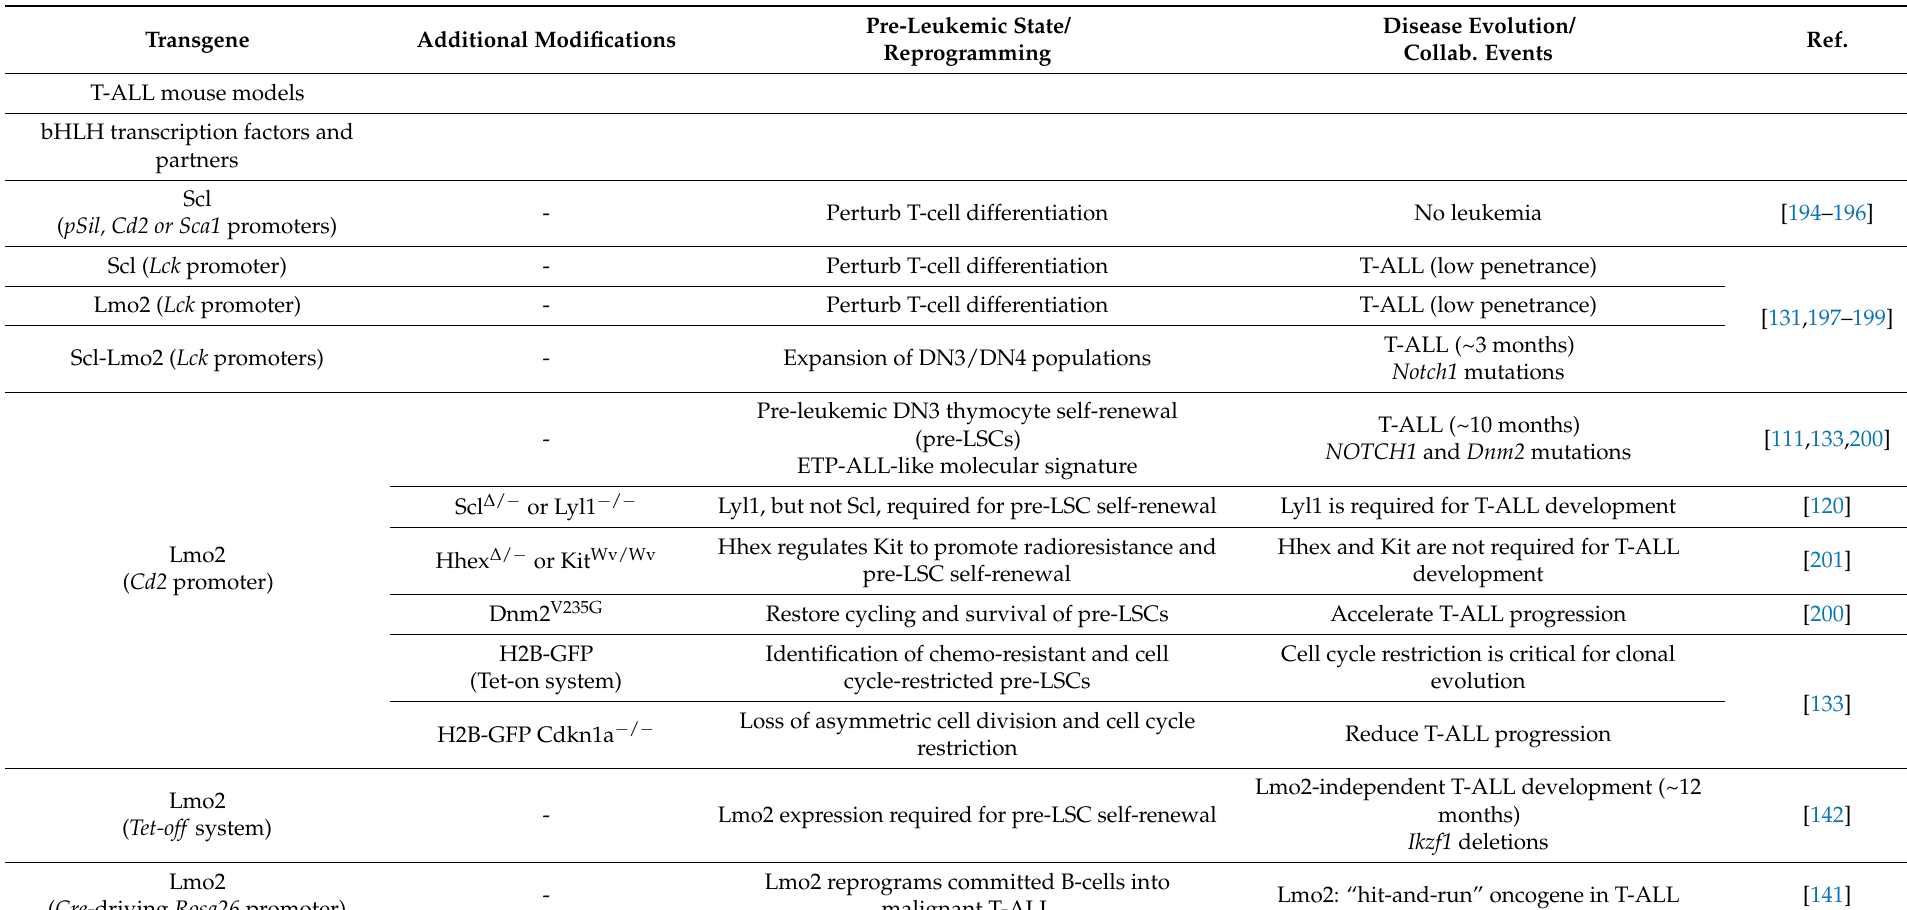
Table 1. T-ALL and B-ALL mouse models exploring the biological mechanisms by which an oncogenic transcription factor perturbs normal hematopoietic development during the pre-leukemic phase and leads to malignant